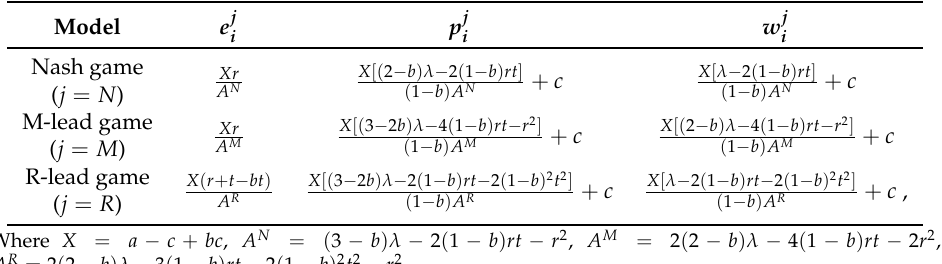
Table 1. Optimal